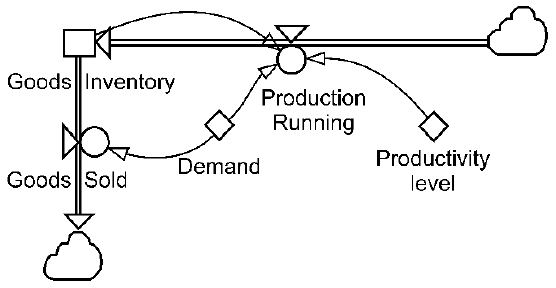
Figure 3. Stock and flow diagram (SFD) of goods inventory in production operation.